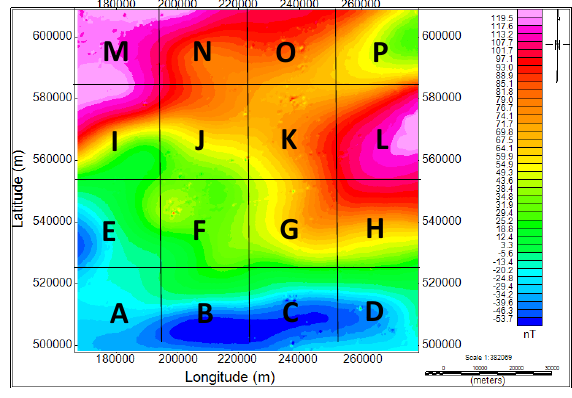
Figure 12: Sixteen spectral blocks for geothermal analysis.